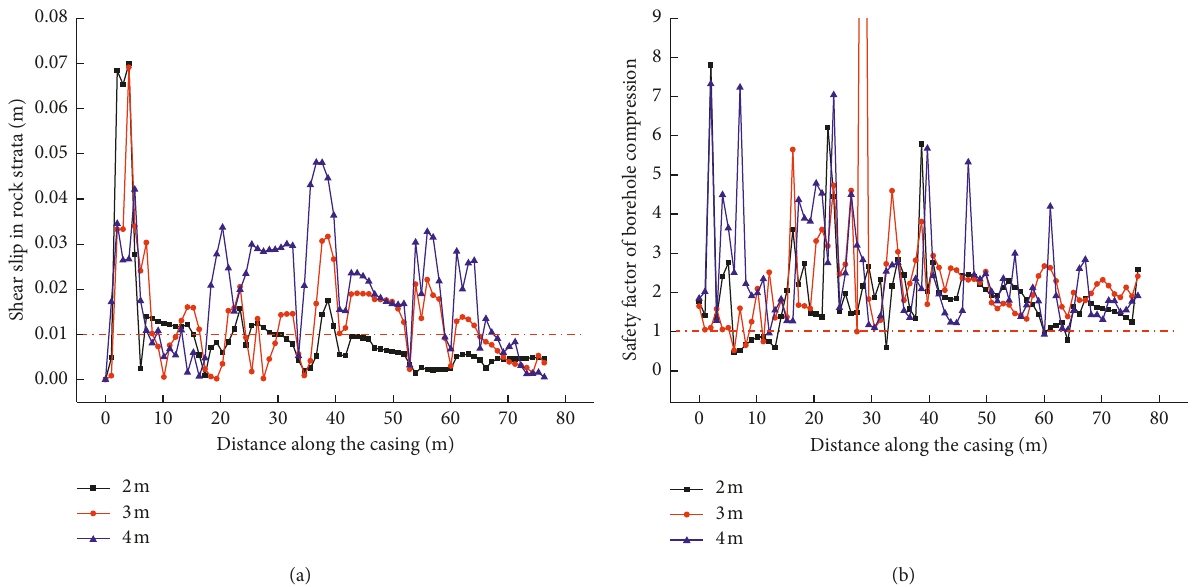
Figure 12: Effect of mining height on the stability of the borehole. (a) Effect of mining height on the shear stability of the borehole. (b) Effect of mining height on the compressional stability of the